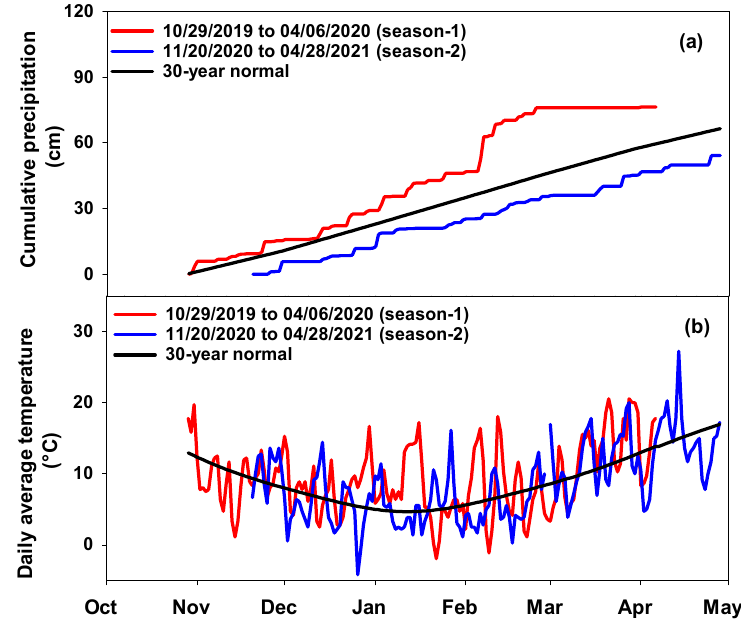
Figure 1. Cumulative precipitation ( a ) and daily average temperatures ( b ) from planting through the harvest of cover crops in comparison with the 30 year normal data. Cumulative precipitation normals for the 160 d period in both seasons were calculated from the daily precipitation normal for a period of 30 years from 1991 to 2020. Precipitation and temperature data were obtained from the South Carolina State Climatology Office, a division within the South Carolina Department of Natural Resources.